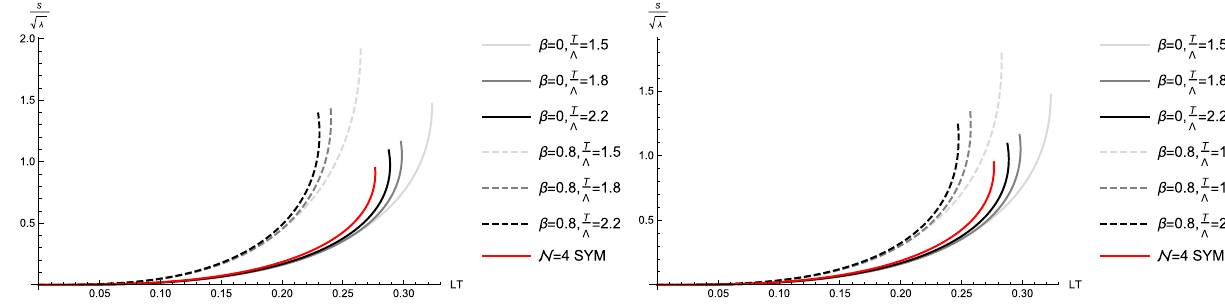
√ λ versus LT in different values of T /(cid:2) and β : Left: (cid:10) = π/ 2, Right: (cid:10) = 0 Fig. 6 The large black hole. S /